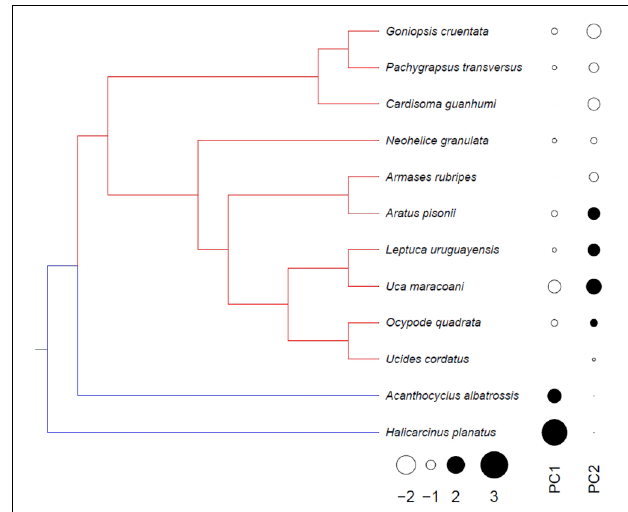
FIGURE 7 | Overall physiological evolution of thermal tolerance, grouping systemic and kinetic traits in intertidal crabs distributed from northern Brazil to southern Patagonia, mapped onto a phylogeny modified from Faria et al. (2017). Different colors represent adaptive peaks identified using the SURFACE method: the first optimum (blue) was detected for the sub-Antarctic species while the second (red) was found in the tropical and subtropical representatives. Using a phylogenetic PCA, the first two dimensions accounted for 54.3% of total physiological variance, specifically 38.1% for PC 1 and 16.2% for PC 2 . The scores of both dimensions follow the same phylogenetic pattern as the adaptive peaks. Microhabitat temperature, LL 50 and UL 50 were the most important parameters in both analyses ( R ≥ 0.30 for pPCA, − 14 < AIC < − 8 for